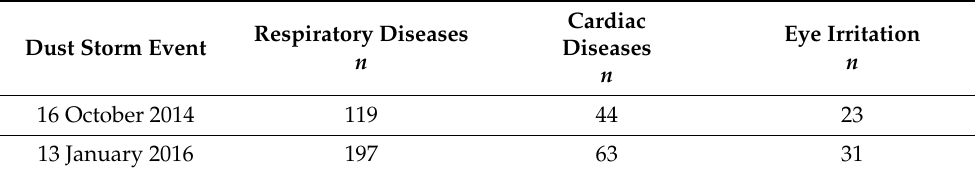
Table 2. Study outcomes of interest from the hospital admissions from the date of the two dust storm events and up to 40 days after the events. Motor vehicle accidents are not included. It is important to note that motor vehicle accidents in the days after the dust storms may not be connected to these events, bearing in mind that poor visibility may occur for only a few days after a dust storm event. Hence, we did not include them in this